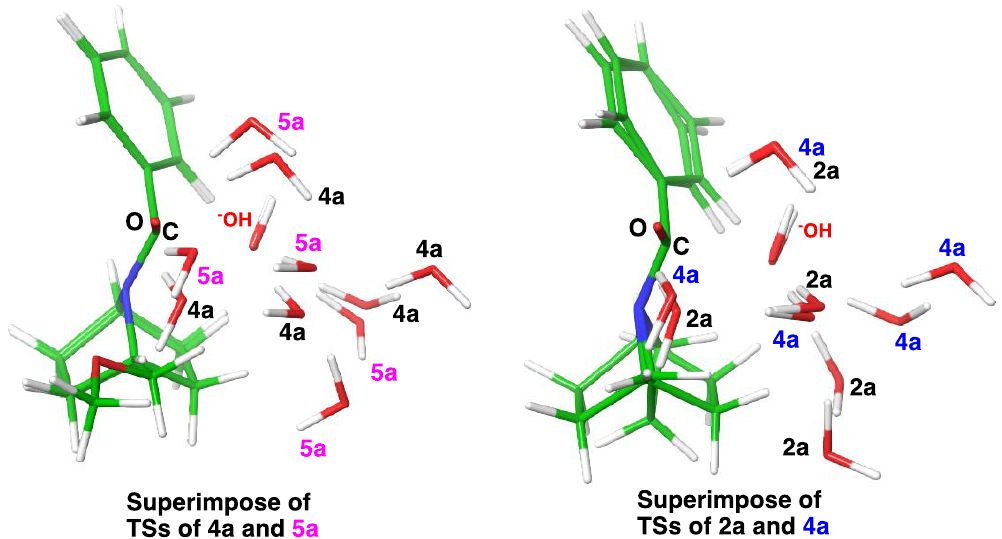
Figure 13. Superimposed TS structures of 4a and 5a (left) and 2a and 4a (right), showing the disrupted water network in bulky 5a (left, magenta) and 4a (right, blue).